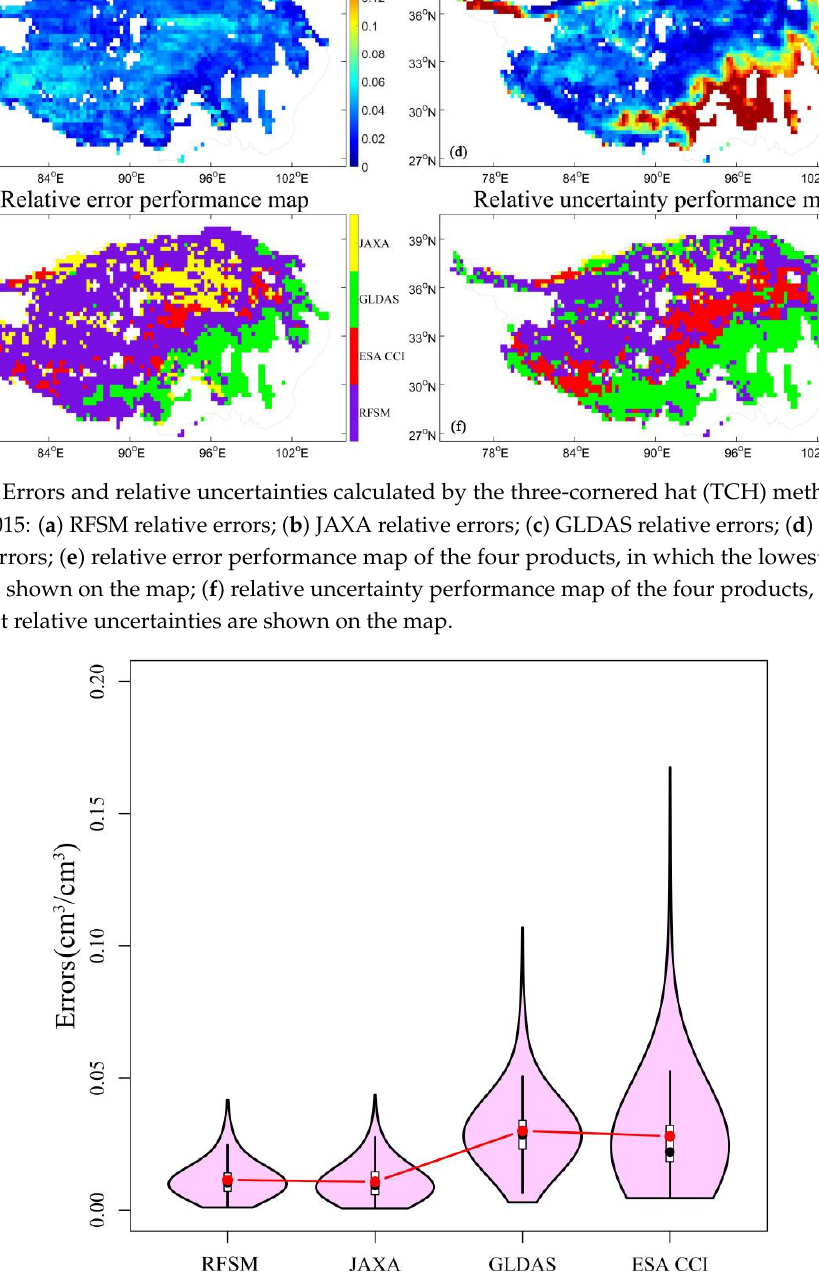
Figure 9. Distribution of the relative errors of RFSM, JAXA, GLDAS and ESA CCI calculated by the TCH